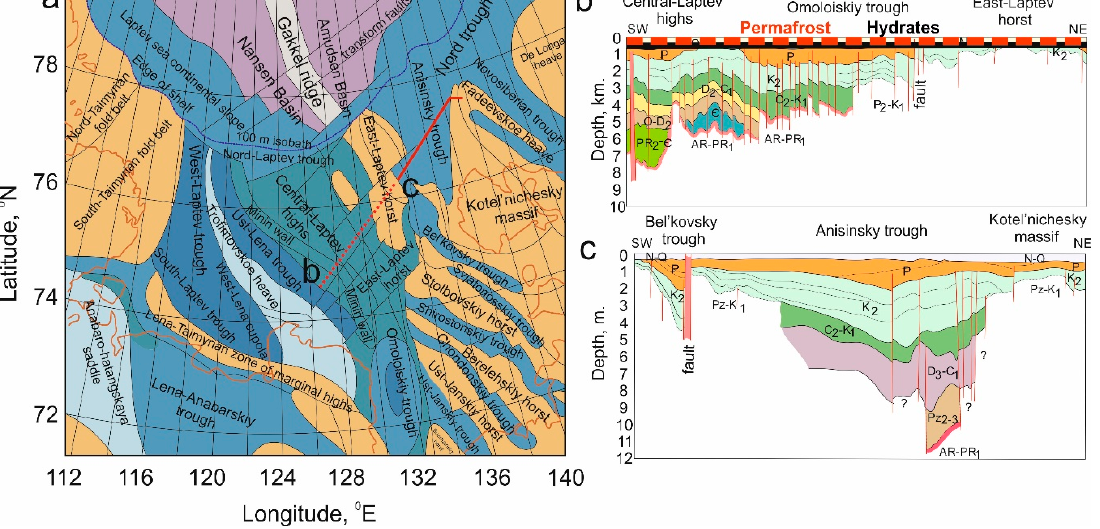
Figure 2. Geological structure and sedimentary drape on the ESAS. ( a ) Major geological structures defined in the ESAS; red dotted line marked b corresponds to position of the transect presented in panel ( b ); red solid line marked c corresponds to positions of the transects presented in panel ( c ). ( b ) Example of the structure and thickness of the sedimentary drape (over the Central–Laptev highs, Omolonskiy trough, and East Laptev horst) and comparable thickness of permafrost and associated hydrates (including hydrate stability zone, HSZ) shown as dotted red and solid black lines. ( c ) Example of the structure and thickness of the sedimentary drape (over the Belkovsky and Anisimov troughs and Kotel’nichevsky massif; other examples as well as detailed descriptions of terms and legends used can be found in [30]).